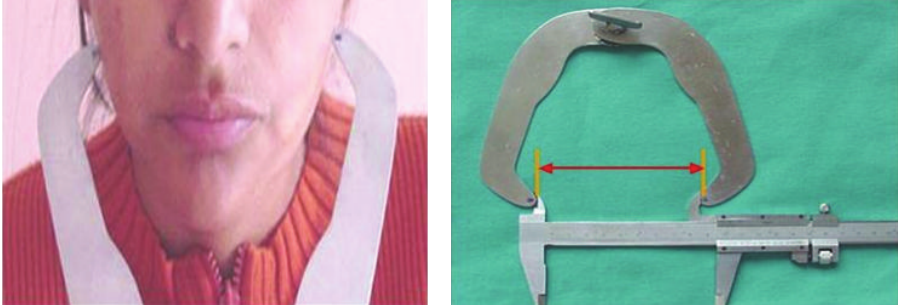
Figure 4: Inflammation measurement by vernier calibrators.